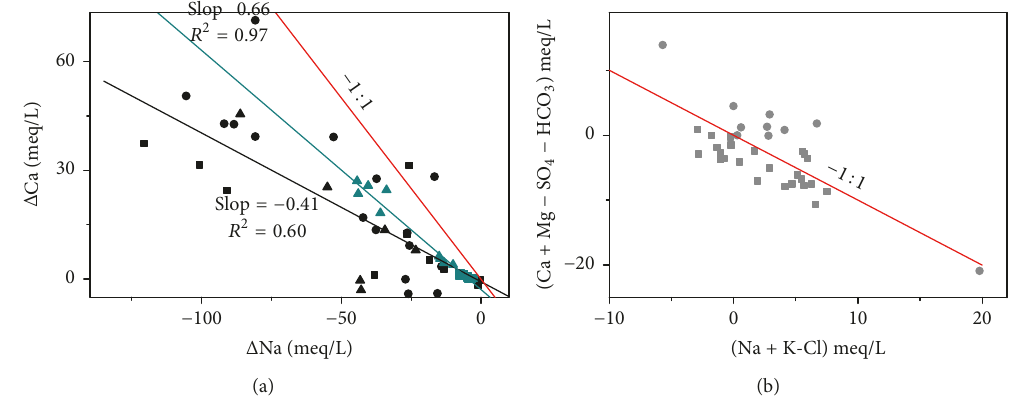
Figure8: (a) Δ Caversus Δ Na; (b)(Ca 2+ +Mg 2+ -HCO 3− -SO 42− )versus(Na + +K + -Cl − )ofaquitard porewater. Symbols arethesameas Figure 6.